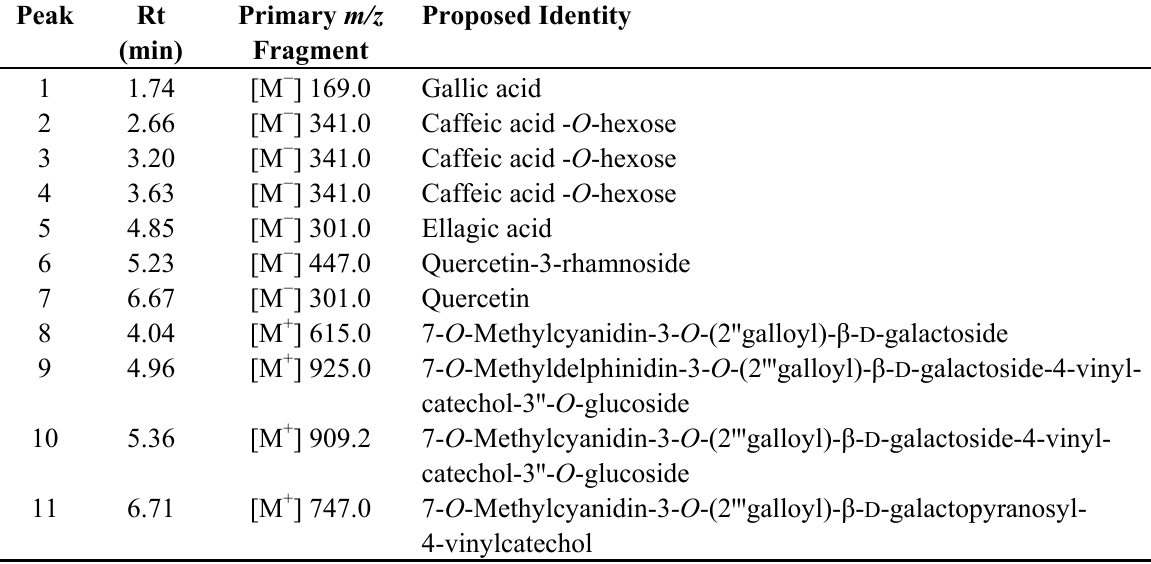
Table 4. Peak assignment, retention time (Rt) and mass spectral data of compounds detected in Chinese sumac